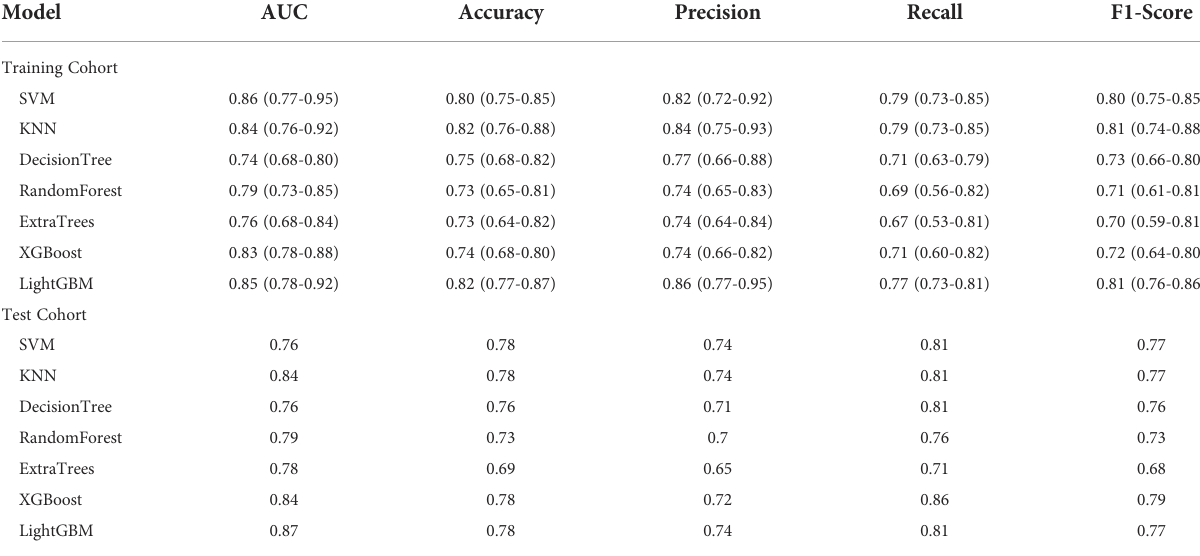
TABLE 3 The performance of deep-learning features for the prediction of ALN metastasis.